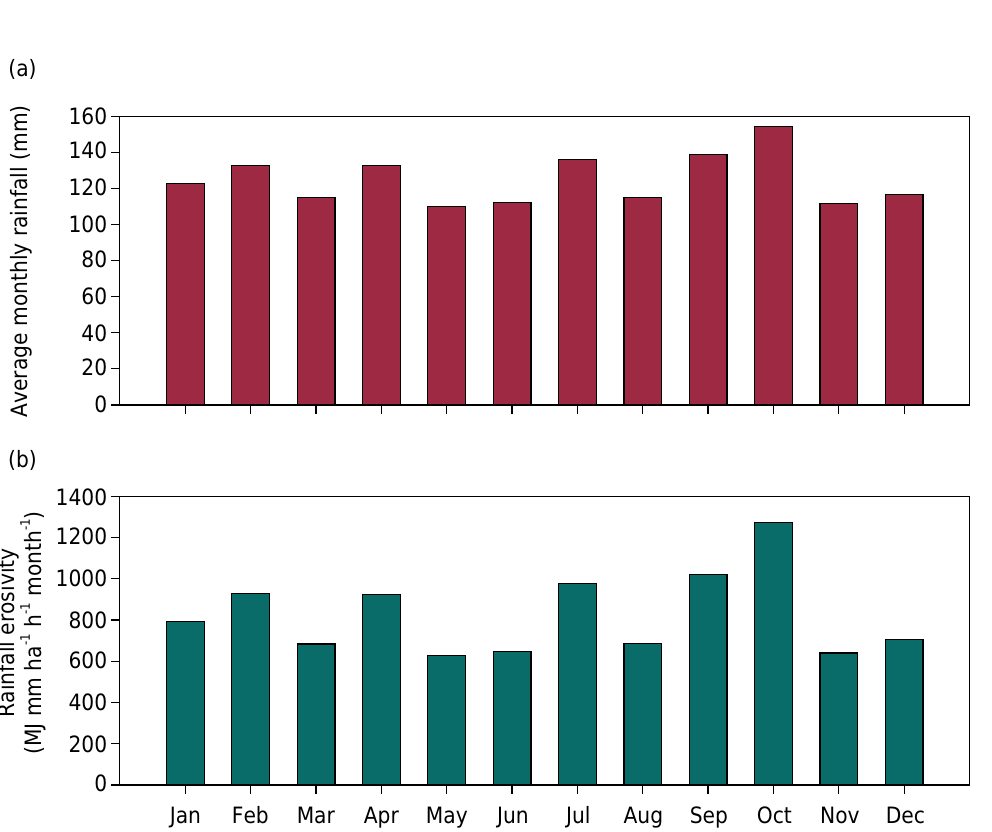
Figure 3. Analysis of (a) average monthly rainfall and (b) rainfall erosivity in the Candiota region.